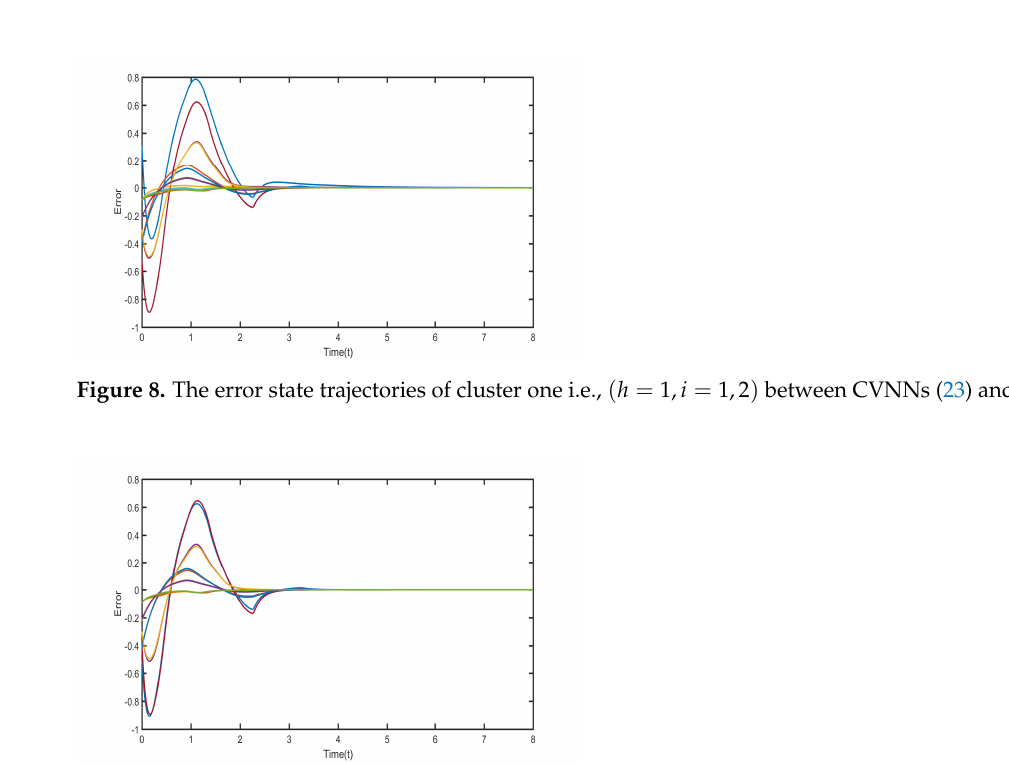
Figure 9. The error state trajectories of cluster two i.e., ( h = 2, i = 3,4 ) between CVNNs (23) and